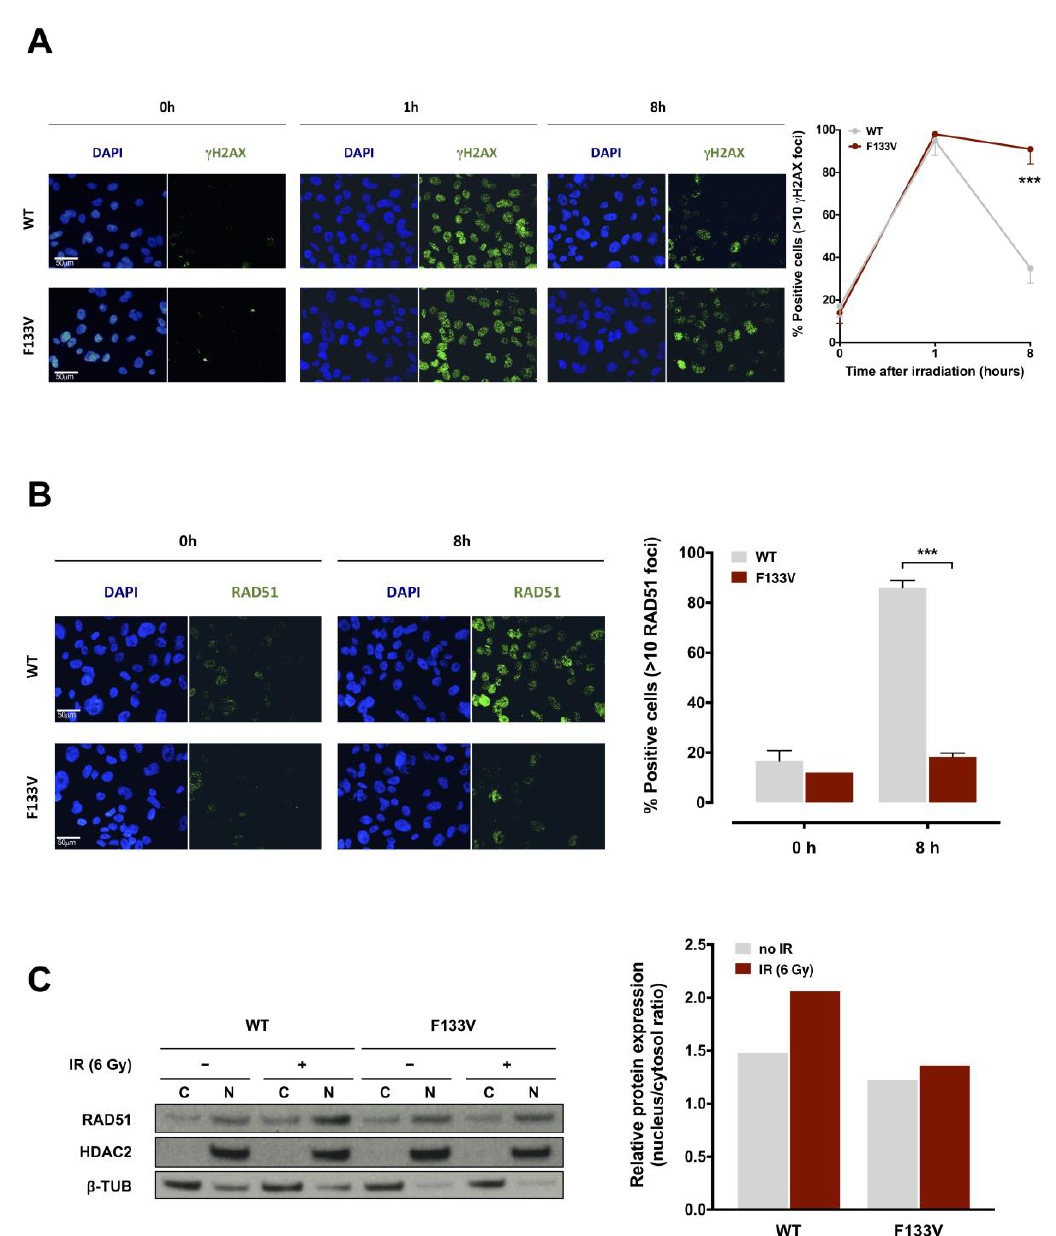
Figure 4. F133V SPOP impairs cell ability to recover from radiation-induced DNA damage. ( A ) (Left panel) Representative immunofluorescence microphotographs of nuclear γ H2AX foci in DU145 WT or F133V SPOP cells at 0, 1 and 8 h upon 6 Gy irradiation. (Right panel) Quantification of γ H2AX foci in WT or F133V SPOP DU145 cells, expressed as mean percentage of cells containing > 10 γ H2AX foci at 0, 1 and 8 h upon irradiation. Data are reported as mean ± SD values. The level of significance was represented as *** p < 0.001, Student’s t -test. ( B ) (Left panel) Representative immunofluorescence microphotographs of RAD51 nuclear foci in DU145 WT or F133V SPOP cells at 0 and 8 h upon irradiation (6 Gy). (Right panel) Quantification of RAD51 foci expressed as mean percentage of cells containing > 10 RAD51 foci at 0 and 8 h upon irradiation (IR). Data are reported as mean ± SD. ( C ) Western blot analysis and relative quantification of RAD51 protein levels in nucleus / cytosol fractions of DU145 WT or F133V cells at 0 and 8 h upon irradiation (6 Gy). HDAC2 and β -tubulin were used as equal protein loading controls for nuclear and cytosolic fractions, respectively. Relative protein expression 1 was calculated as nuclear / cytosolic ratio of normalized RAD51